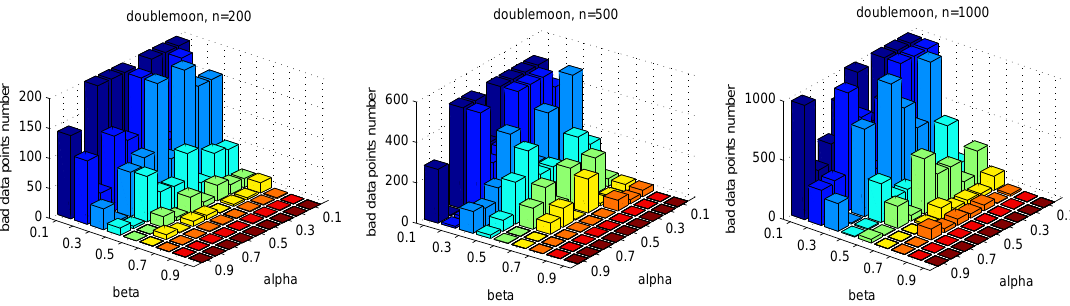
Figure 18. Number of “bad data points” found under different α and β combinations in datasets with different data numbers.